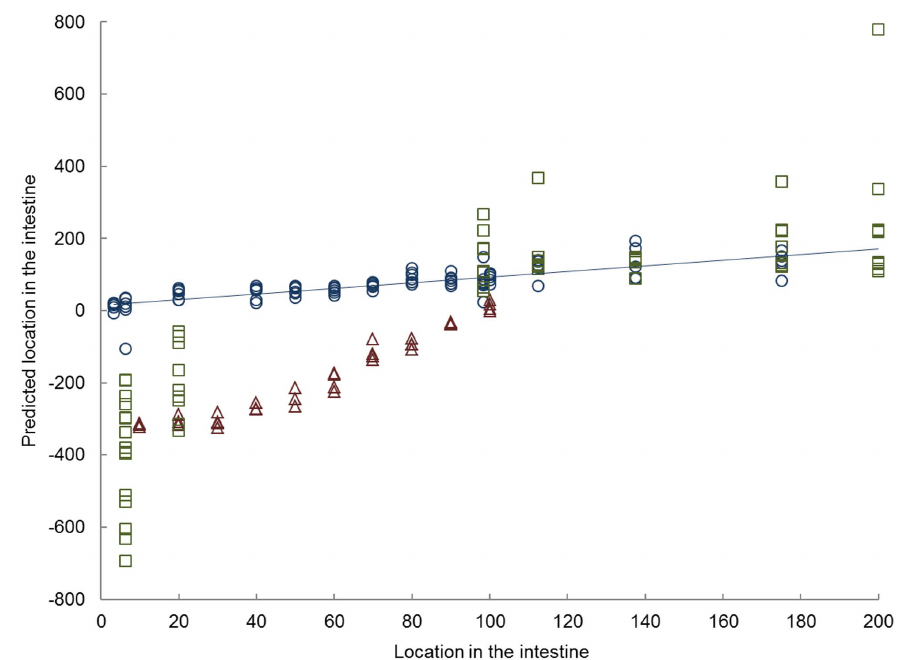
Figure 1. Partial least square analysis. Results of partial least squares (PLS) model in which porcine gene expression data ( O ) were used for regression analysis with locations in the intestine and the human ( % ) and murine data ( D ) were projected in the model. The PLS prediction model used 5 factors and has a R 2 =0.6541. The x-axis shows the location in the intestine, in which 0–100 resembles the small intestine from proximal to distal, 100–200 resembles the large intestine.